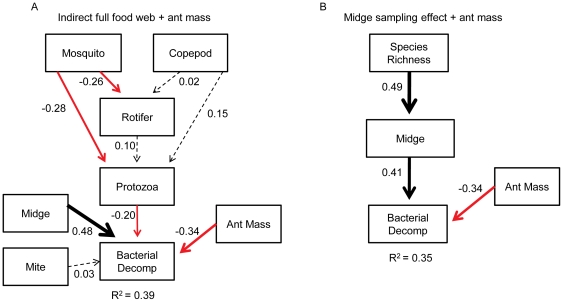
Best-fit path models describing decomposition dynamics in the Sarracenia food web.The indirect full food web model including ant mass (A) was the top overall model and the midge sampling effect model including ant mass (B) was the top sampling effect path model explaining decomposition by bacteria (Decomp) in the Sarracenia food web. Standardized path coefficients are shown for each link and arrows are proportional to the magnitude of the coefficient. Solid black lines indicate significant (P<0.05) positive relationships and solid red lines indicate significant negative relationships. Dashed lines indicate non-significant relationships. The R2 value shows the amount of variation in decomposition explained by the path model.